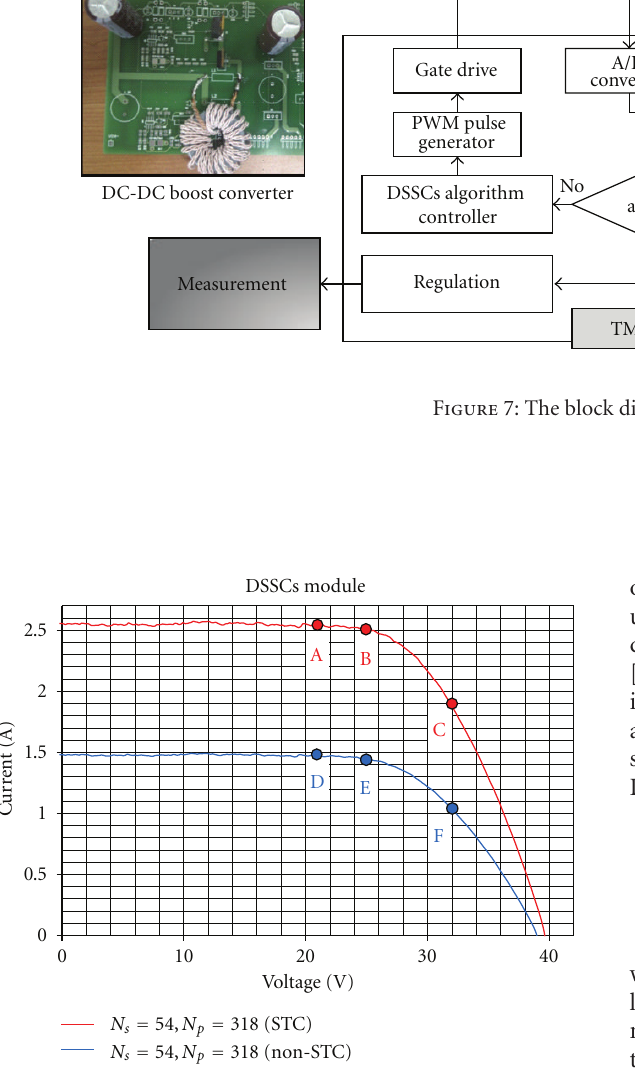
Figure 8: The I - V characteristic curves of DSSCs module ( N S = 54, N P =